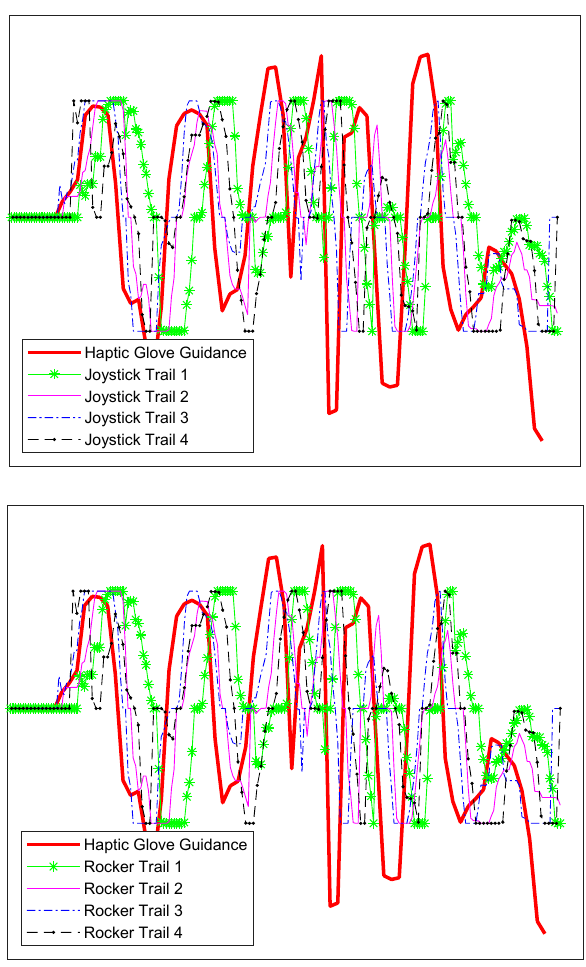
Figure 14. Haptic glove guidance versus joystick records.